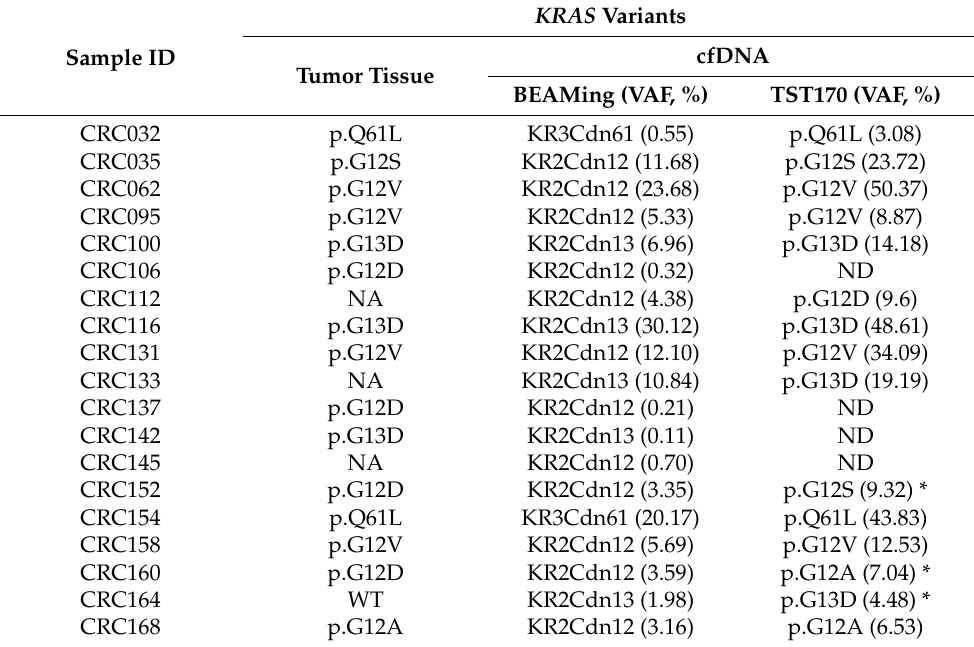
Figure 3. Distribution of KRAS variants detected in cfDNA of mCRC patients ( n = 19) by TST170. ( A ) Frequency of CRC patients with KRAS variants detected in cfDNA by TST170. ( B ) Frequency of KRAS variants detected in cfDNA by TST170 according to codon location. Table 2. KRAS variants detected in tumor tissues and cfDNA in mCRC patients ( N =